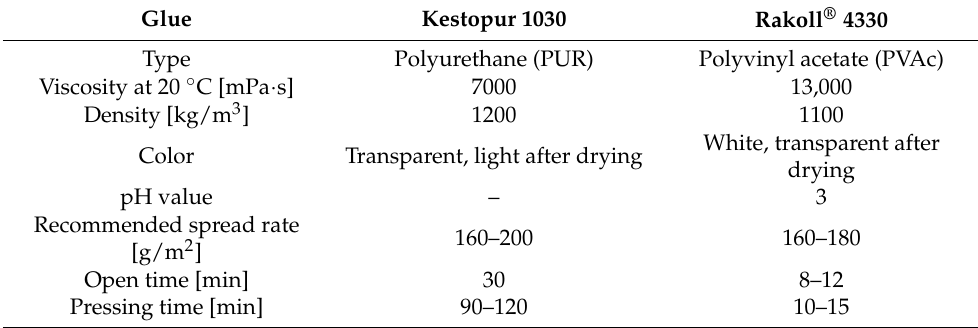
Table 1. Physical and chemical characteristics of glues